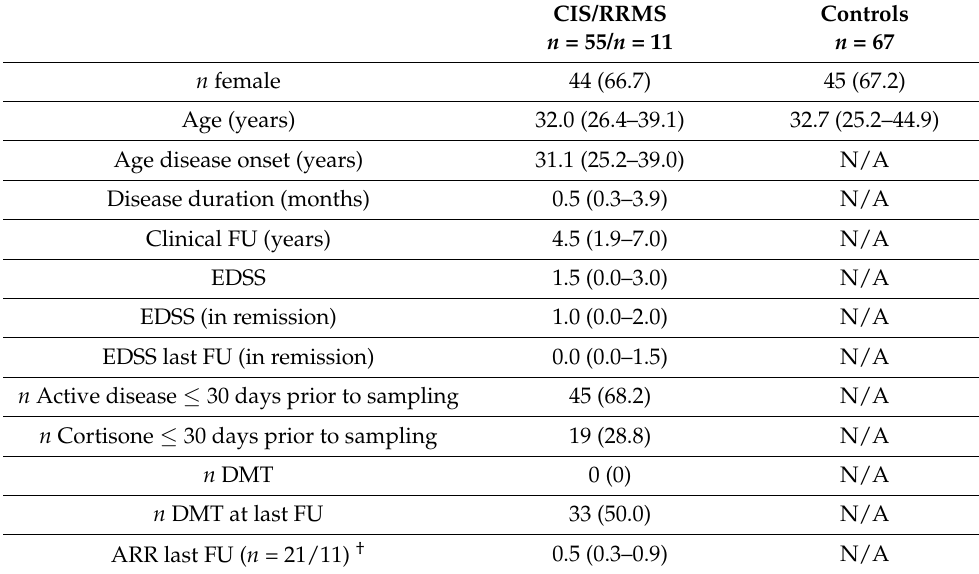
Table 1. Demographic and clinical data of study